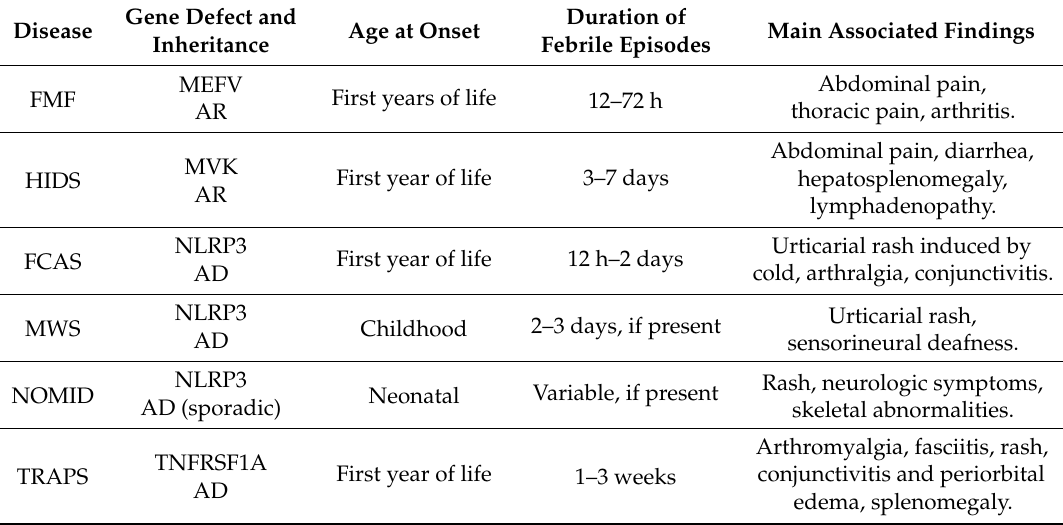
Table 5. Monogenic autoinflammatory diseases presenting with recurrent